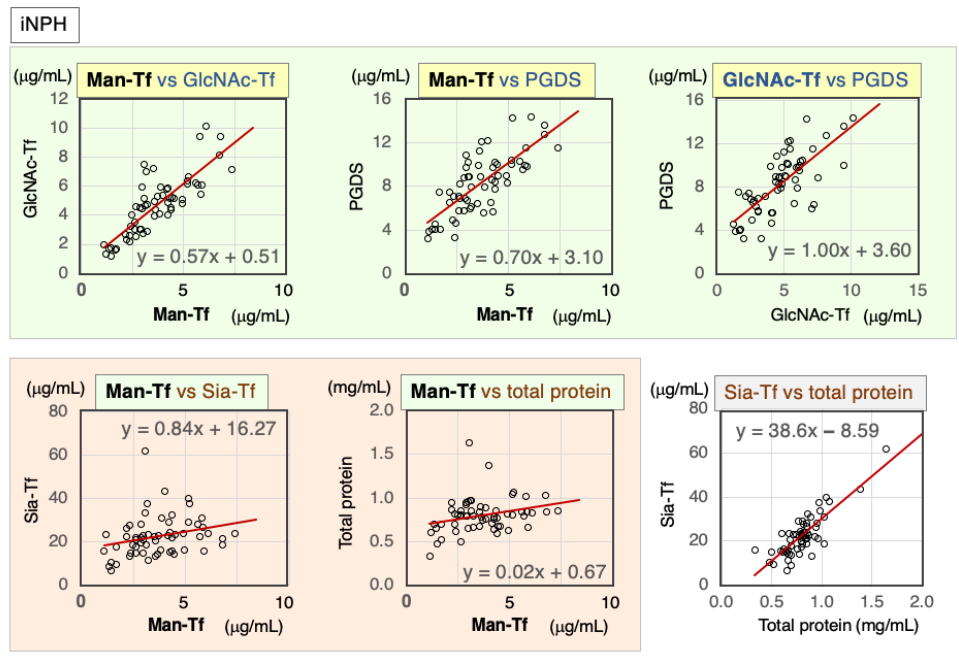
Figure 6. Scatter diagrams and regression lines of marker combinations for iNPH patients. Table 5. Correlation coefficients and data normality of markers.